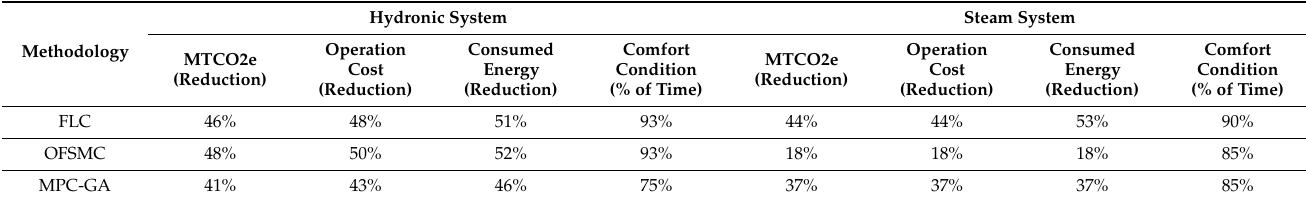
Table 8. Comparison of controllers’